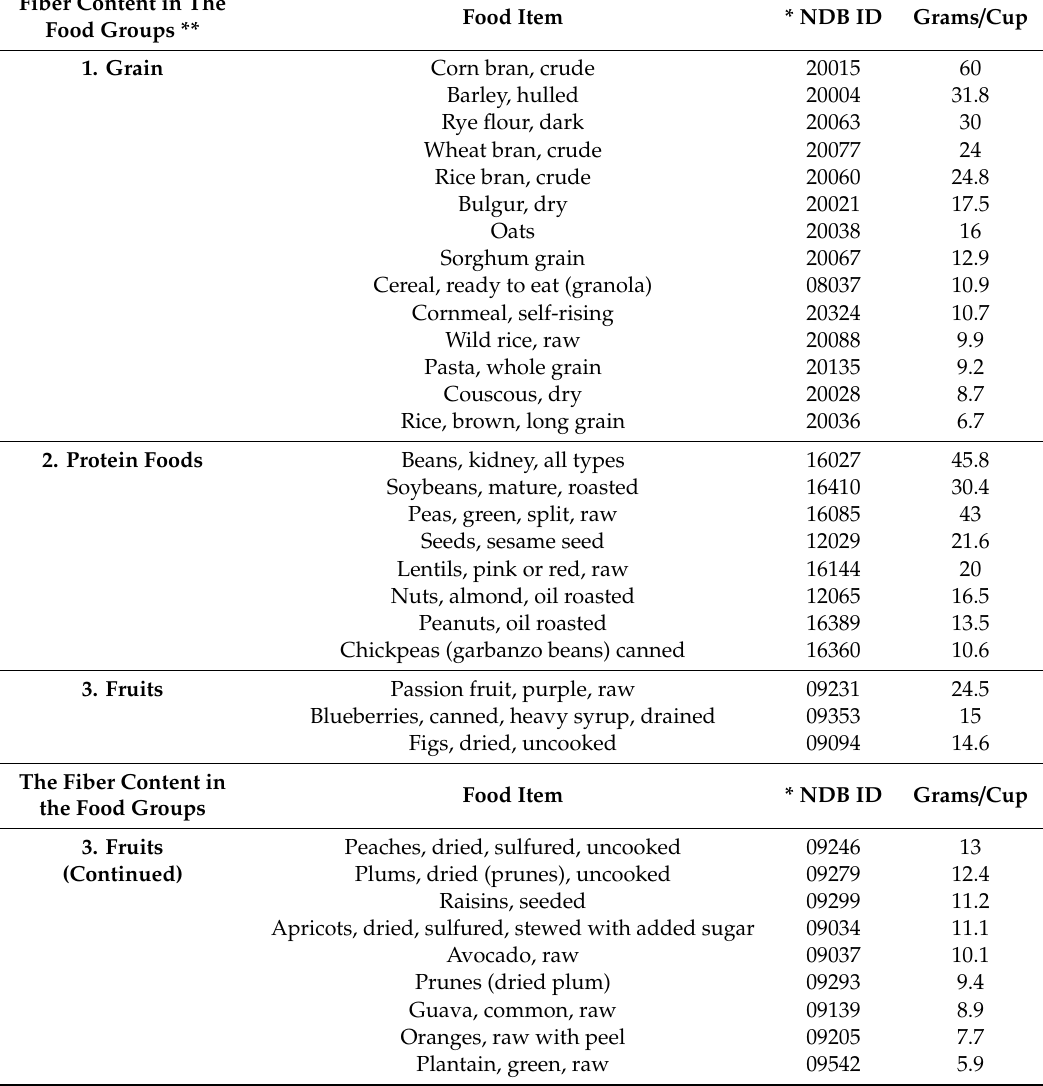
Table 1. Select sources of dietary fiber in the food